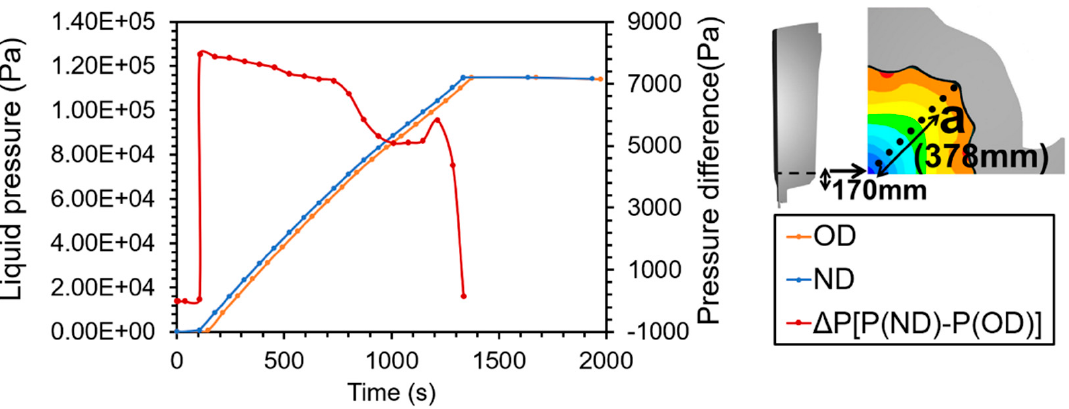
Figure 9. Static liquid pressure in OD and ND at point a, a height of 170 mm from the bottom and 378 mm in a radial direction from the center .